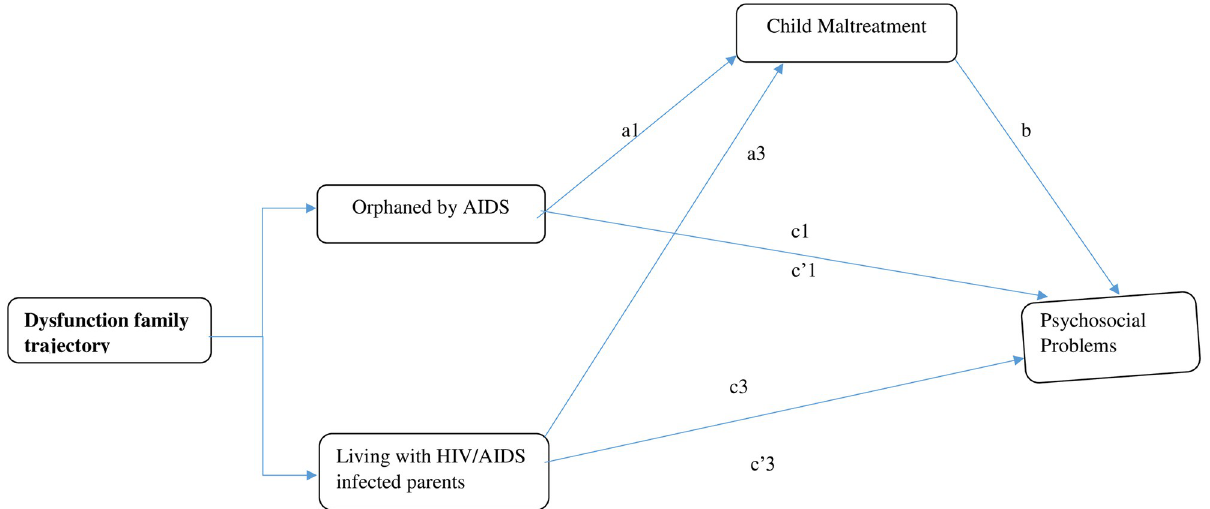
Fig 2. Observed model. A mediation model of association between HIV/AIDS family dysfunction trajectories and psychosocial problems through child maltreatment. a 1, a 2, and a 3 = the relative effects of orphanhood by AIDS, orphanhood by other causes, and living with HIV/AIDS infected parents, respectively, relative to the intact family group, on child abuse. b = the association between child maltreatment and psychosocial problems after controlling for covariates. c 1, c 2, and c 3 = relative total effects of orphanhood by AIDS, orphanhood by other causes, and living with HIV/AIDS infected parents, respectively, relative to the intact family group, on child maltreatment after controlling for covariates. c’ 1, c’ 2, and c’ 3 = relative direct effects orphanhood by AIDS, orphanhood by other causes, and living with HIV/AIDS infected parents/caregiver, respectively, relative to the intact family group, on child maltreatment after controlling for relevant